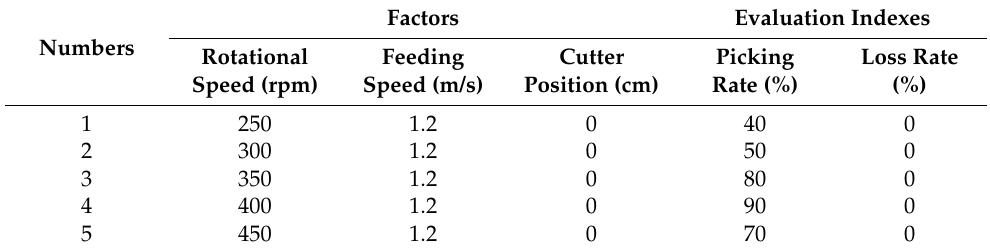
Table 1. Results of the single-factor test of the clamping-picking device speed.